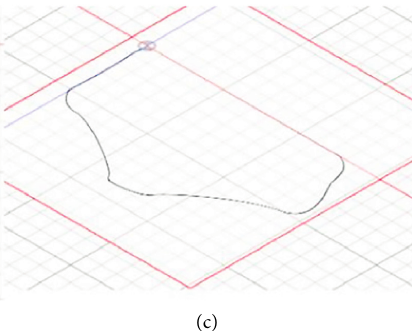
Figure 6: Top view and oblique top view of the trajectory. (a) The real trajectory. (b) Top view. (c) Oblique view.